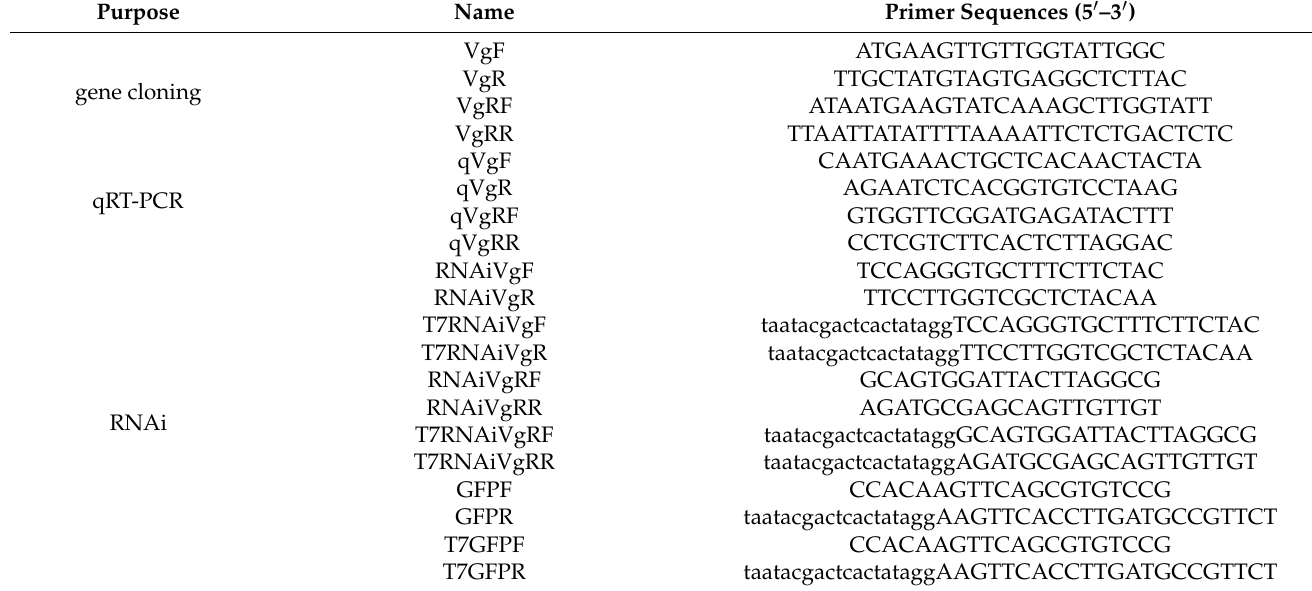
Table 1. Primers used in this